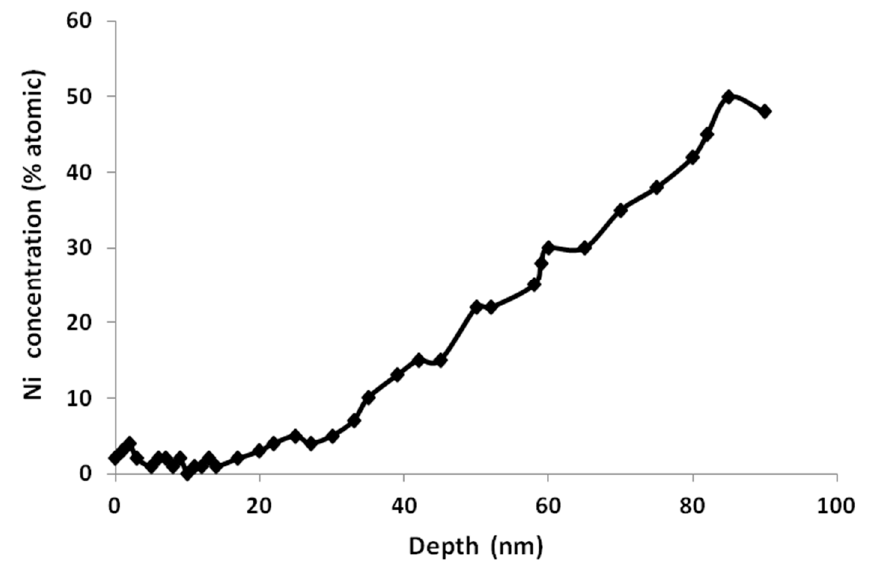
Figure 1. XPS depth profile of the nickel for austenitic alloy, after oxidation treatment.